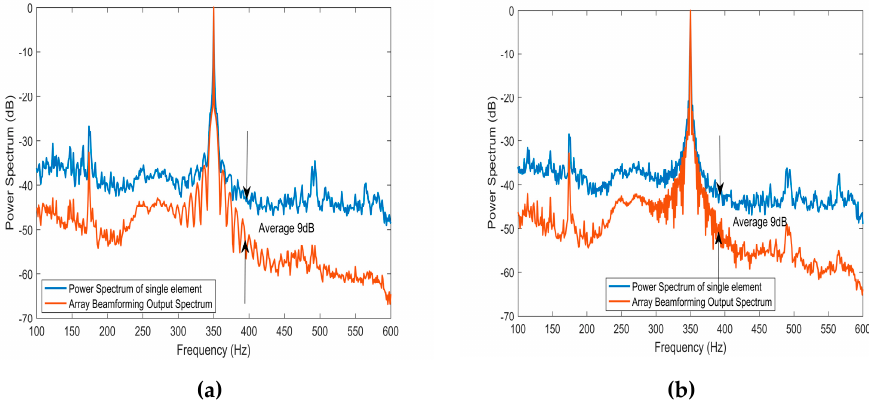
Figure 16. Average array gains (AGs) in the direct ‐ arrival zone ( a ) data in the middle measurement period; ( b ) data in the late measurement period.